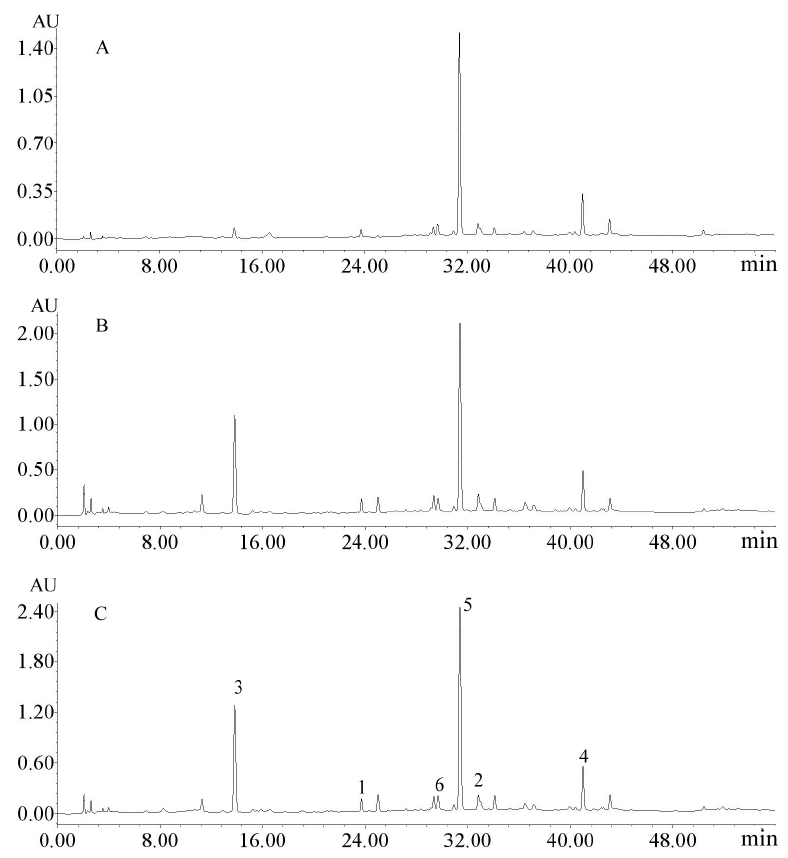
Figure 3. HPLC chromatograms of the extraction samples by ultrasonic ( A ), heat reflux extraction ( B ), and UPE ( C ) from Ligustri Lucidi Fructus. HPLC conditions: column, Purospher STAR RP18 Endiapped (250 mm × 4.6 mm i.d., 5 μ m); mobile phase, acetonitrile ( A )-water ( B ), 0–2 min, 5–5%A;